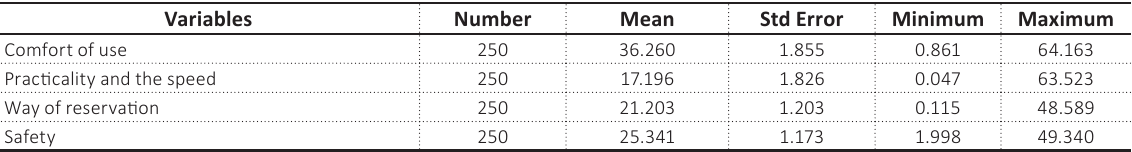
Table 6. Average importance of